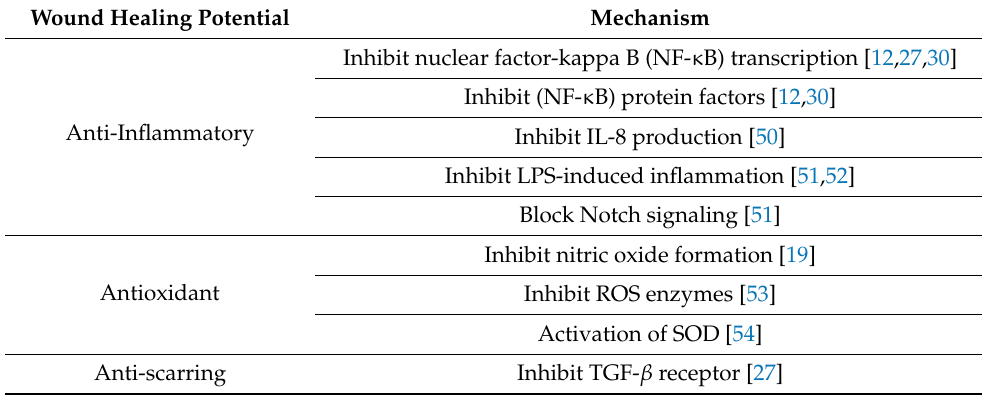
Table 1. Epigallocatechin gallate (EGCG) wound healing